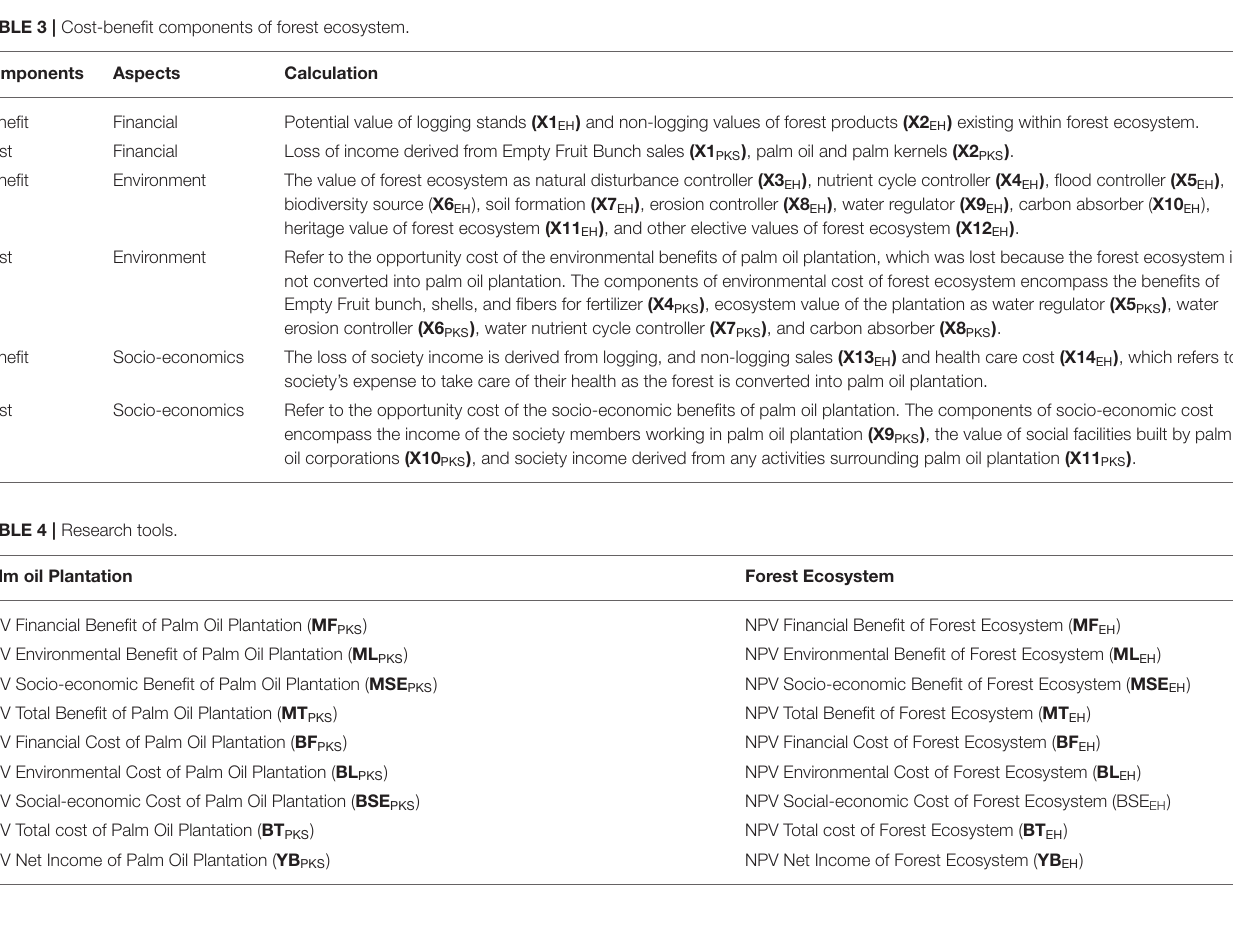
TABLE 5 | Results of the comparison for cost-benefit of financial feasibility for palm oil plantation and forest ecosystem protection (in thousands IDR*). Components